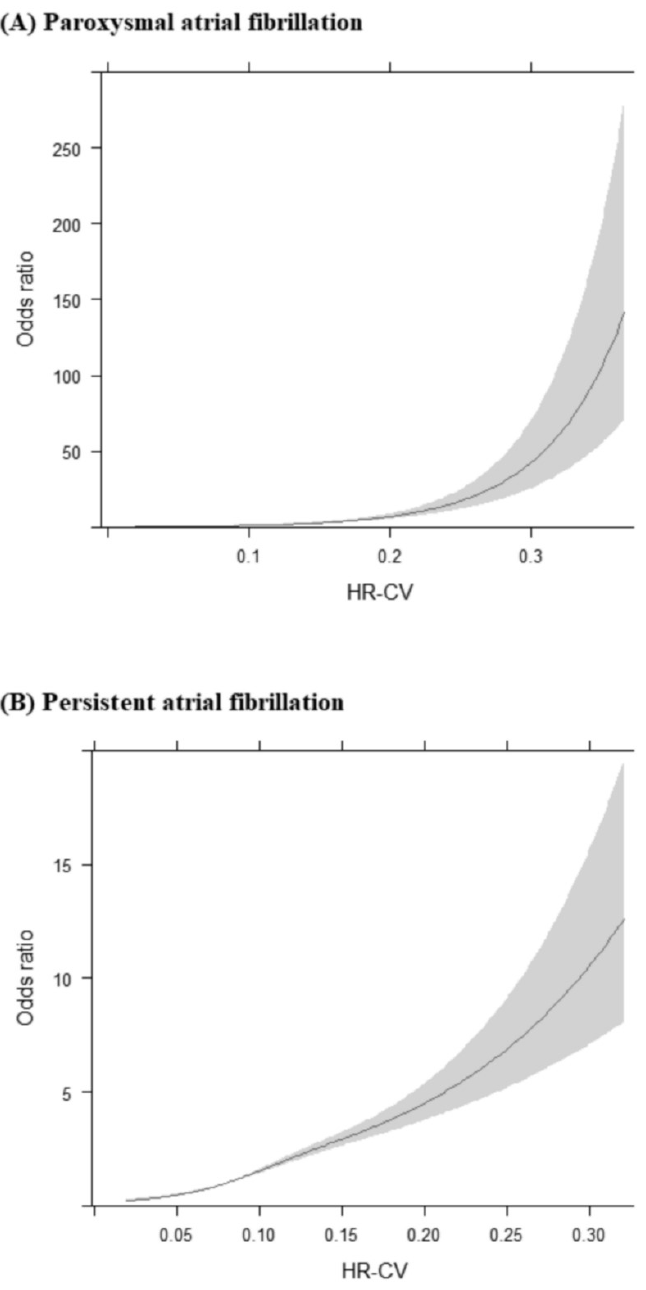
Figure 3. Restricted cubic splines are presented for the associations between HR-CV levels and ( A ) paroxysmal atrial fibrillation as well as ( B ) persistent atrial fibrillation. The analyses were adjusted for all confounders considered in the fully adjusted model, namely age, sex, eNIHSS score, history of hypertension, diabetes mellitus, dyslipidemia, coronary artery disease, congestive heart failure, history of cancer, smoking status, body mass index, total cholesterol, triglycerides, creatinine, alanine aminotransferase, mean heart rate, mean systolic blood pressure, and mean diastolic blood pressure. Abbreviations: HR-CV, coefficient of variation in heart rate; eNIHSS, estimated National Institutes of Health Scale.